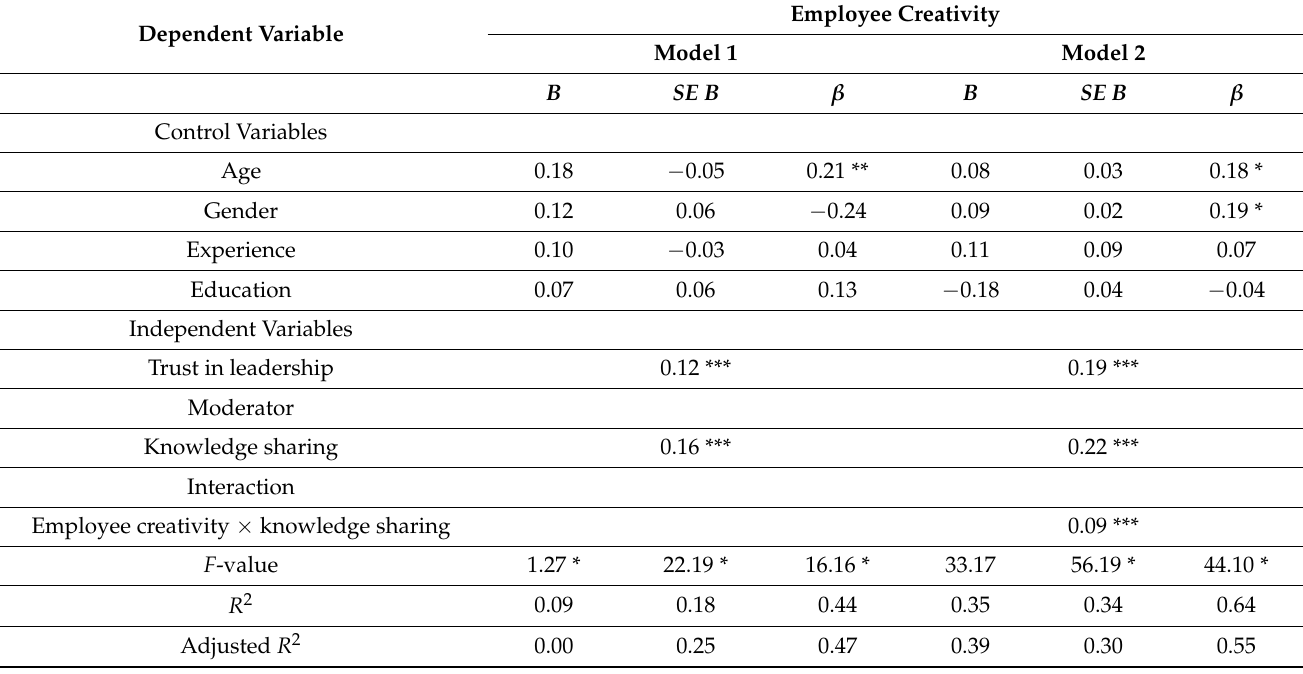
Table 4. Regression